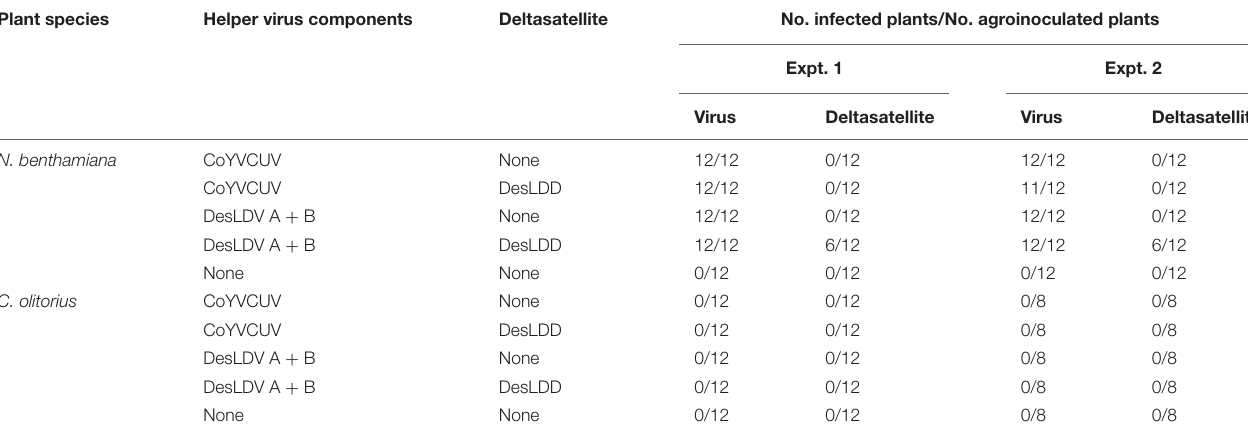
TABLE 5 | Infectivity of Desmodium leaf distortion deltasatellite (DesLDD) in the presence of Corchorus yellow vein Cuba virus (CoYVCUV) and Desmodium leaf distortion virus (DesLDV). Plant